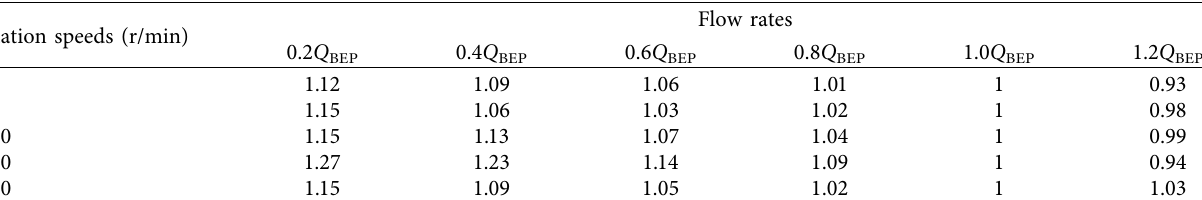
Figure 15: Circumferential component of absolute velocity with infinite blades. Table 2: Deviation coefficient of slip